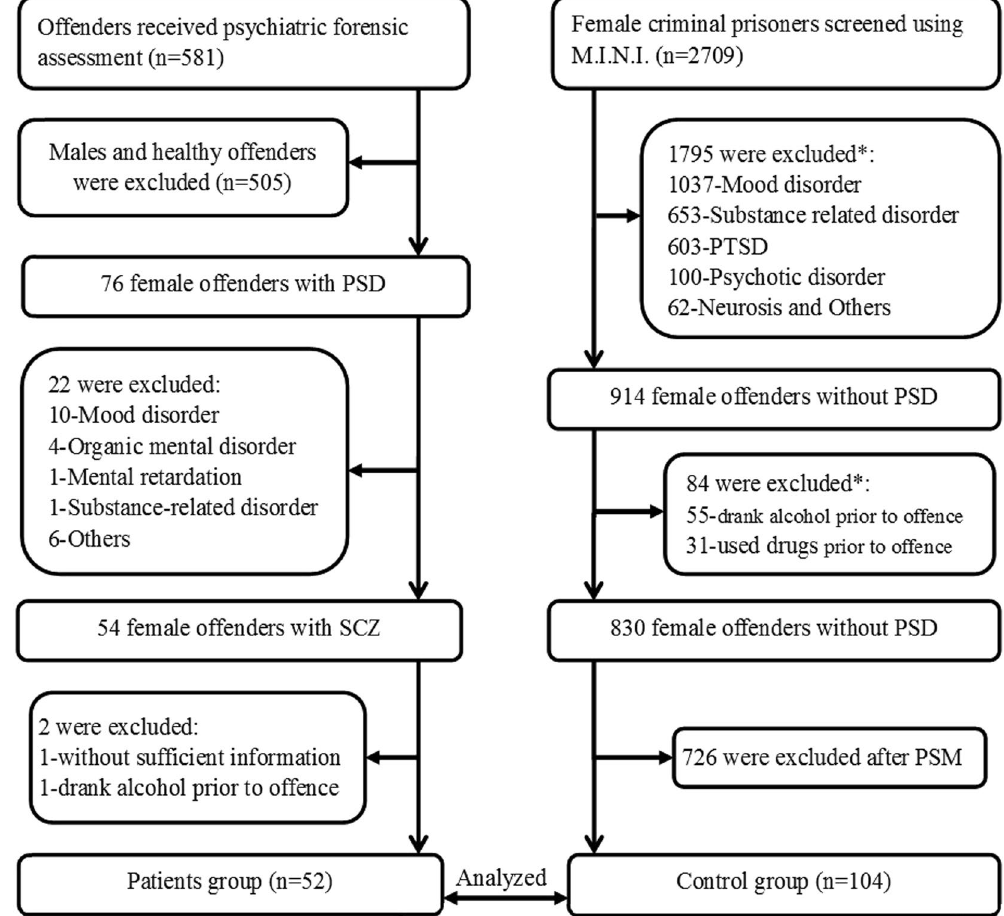
Figure 1. Flowchart of the recruitment process. PSD: psychiatric disorders; PTSD: posttraumatic stress disorder; PSM: propensity score matching; SCZ: schizophrenia; * Some subjects have more than one situations as listed